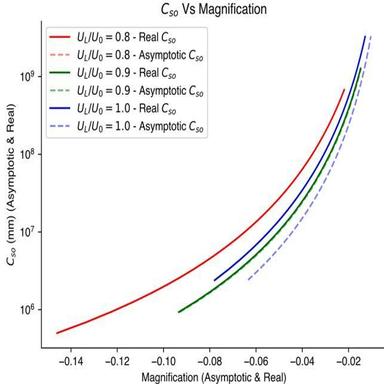
Plot of real & asymptotic spherical aberration coefficients w.r.t the object, against real and asymptotic magnification. As Ul/U0 increases, the real and asymptotic images diverge, including the aberration coefficients. The position of the object on the z-axis was varied between − 100mm and − 600m.